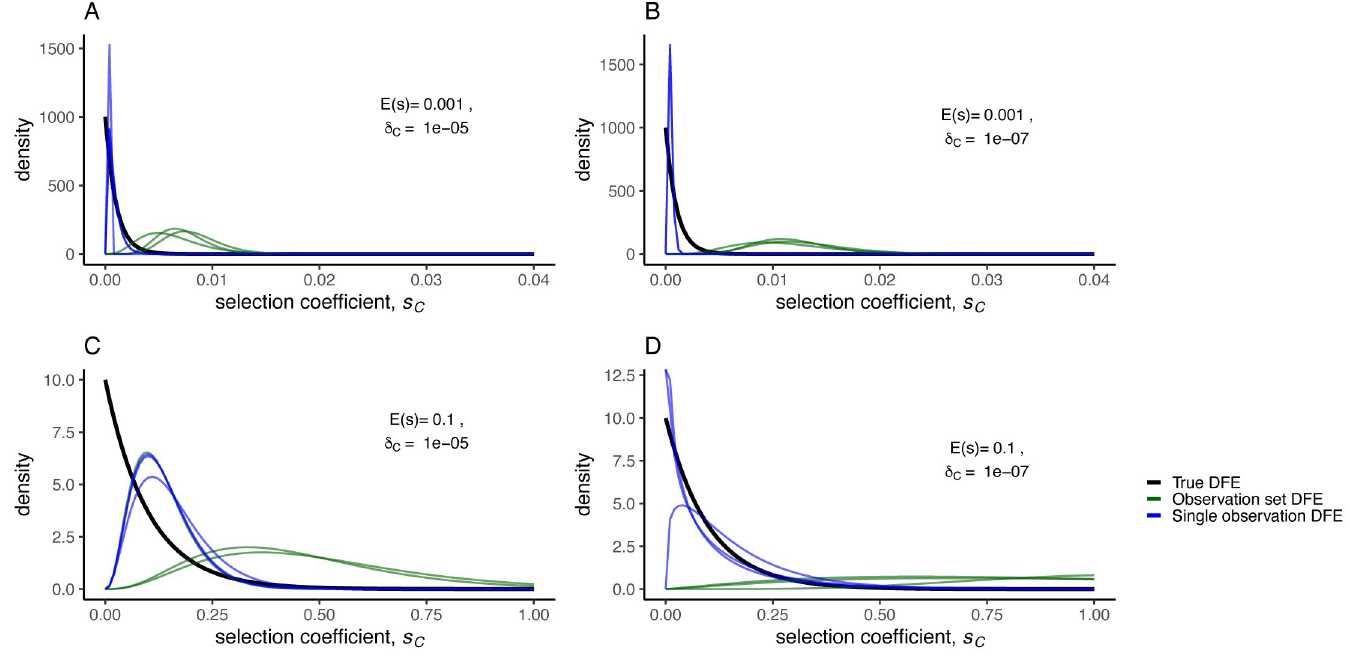
Fig 5. Inference of the DFE. A set of 11 simulated synthetic observations was generated from a WF model with CNV selection coefficients sampled from an exponential (Gamma with α = 1) DFE (true DFE; black curve). The MAP DFEs (observation set DFE, green curves) were directly inferred using 3 different subsets of 8 out of 11 synthetic observations. We also inferred the selection coefficient for each individual observation in the set of 11 separately and fit a Gamma distribution (single observation DFE, blue curves) to sets of 8 inferred selection coefficients. All inferences were performed with NPE using the same amortized network to infer a posterior for each set of 8 synthetic observations or each single observation. (A) weak selection, high formation rate, (B) weak selection, low formation rate, (C) strong selection, high formation rate, (D) strong selection, low formation rate. Data and code required to generate this figure can be found at https://doi.org/10.17605/OSF.IO/E9D5X. CNV, copy number variant; DFE, distribution of fitness effects; MAP, maximum a posteriori; NPE, Neural Posterior Estimation; WF, Wright–Fisher.